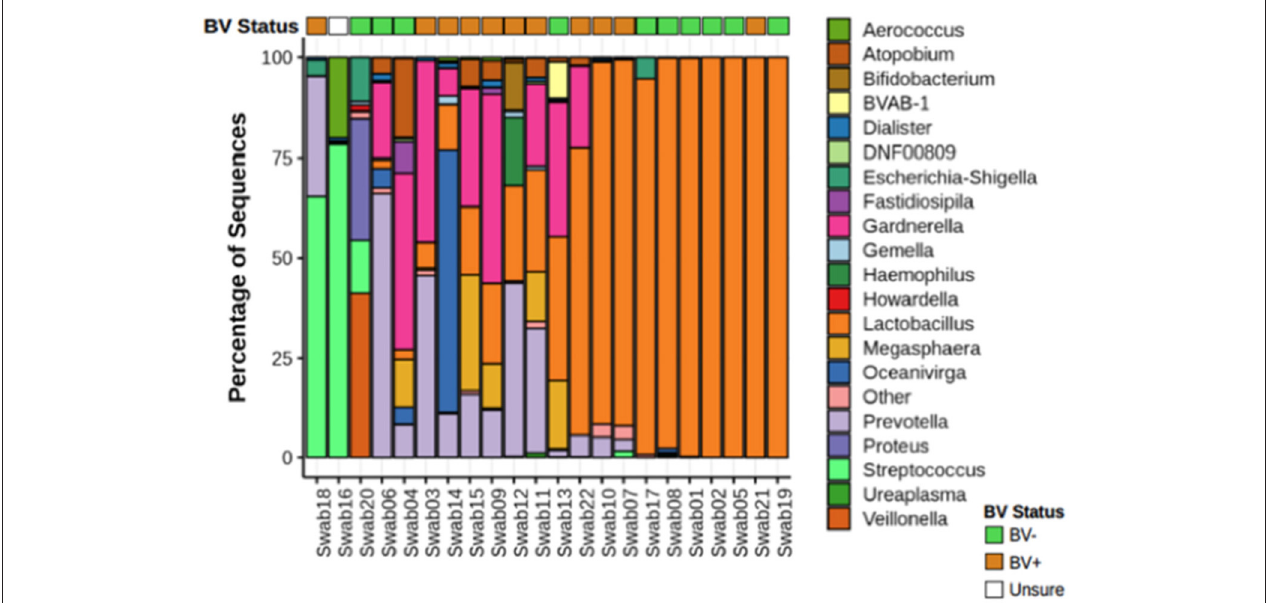
FIGURE 1 | Microbial composition from vaginal swabs. Relative abundance of bacteria from vaginal swabs from women with and without diagnosed BV. Nugent score intermediate was not take in consideration. The 21 most abundant genera are shown. Atopobium genera have now been changed to Fannyhessea . Name was left as Atopobium in the figure to keep consistent with 16S database used for taxonomic